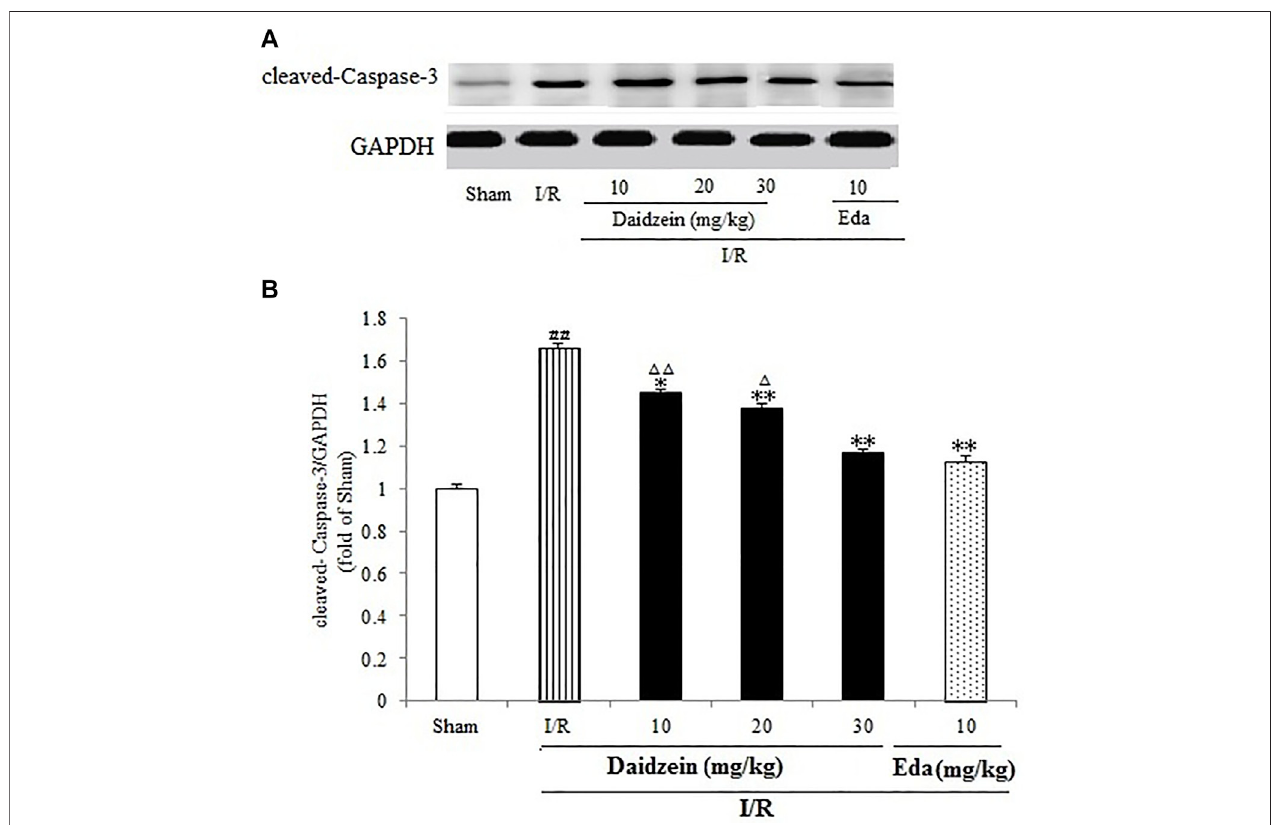
FIGURE 9 | Daidzein treatment decreases the cleaved Caspase-3 level promoted by I/R-treated Rats. (A) Immunoblotting analysis of cleavage Caspase-3. (B) Ratio ofcleaved-Caspase-3/GAPDH.Valuesareindicatedasmeans ± standarderrorsofthemeans(SEMs; n (cid:2) 3). ## p < 0.01noticeablydistinctfrom Sham;** p < 0.05, noticeably distinct from I/R; △ p < 0.05, △△ p < 0.01, compared with the Eda group.